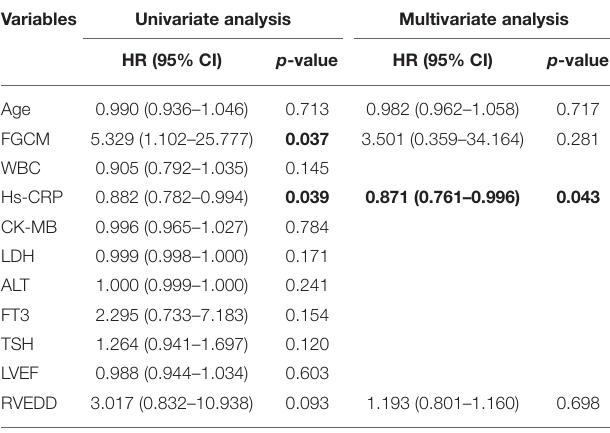
TABLE 3 | Univariate and multivariate Cox regression analysis of factors associated with the occurrence of cardiac death and heart transplantation in the overall population.